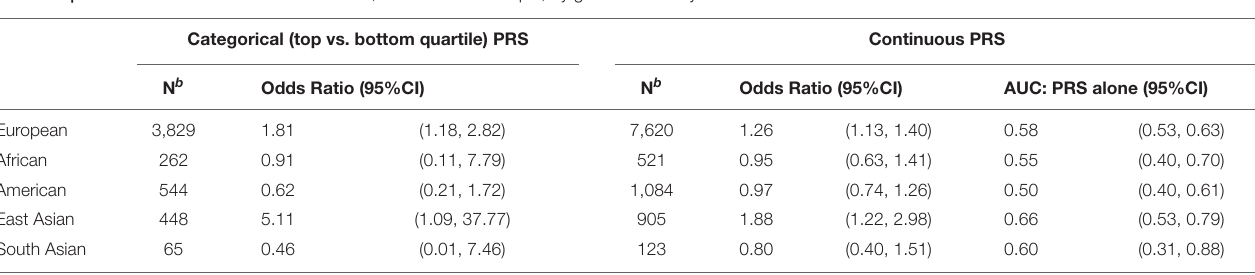
TABLE 2 | Associations between AD PRS and AD, UCLA ATLAS sample, by genetic ancestry. a